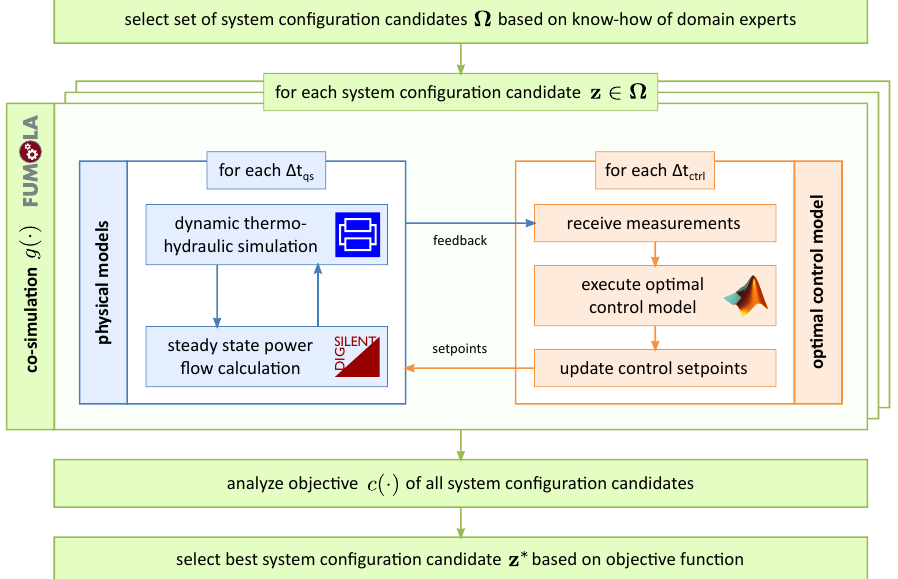
Figure 6. Schematic overview of the OCS workflow applied to the system design of the suburban industrial